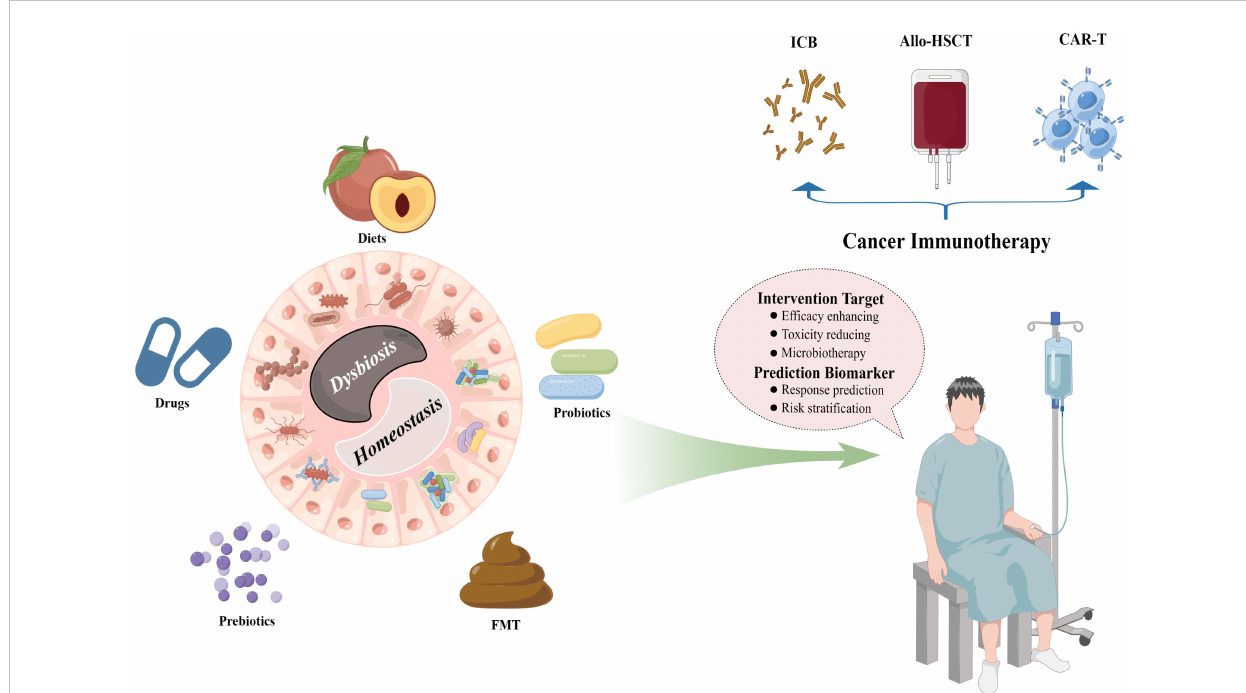
FIGURE 1 Interactions between the gut microbiota and cancer immunotherapy. The intestinal microbial ecosystem can be well modi fi ed by multiple patterns, including diets, drugs, prebiotics, probiotics, and FMT, which provide fascinating opportunities for the clinical managements of diverse cancer immunotherapy protocols such as ICB therapy, allo-HSCT, and CAR-T cell therapy. FMT, fecal microbiota transplantation; ICB, immune checkpoint blockade; allo-HSCT, allogeneic hematopoietic stem cell transplantation; CAR-T, chimeric antigen receptor T. (By